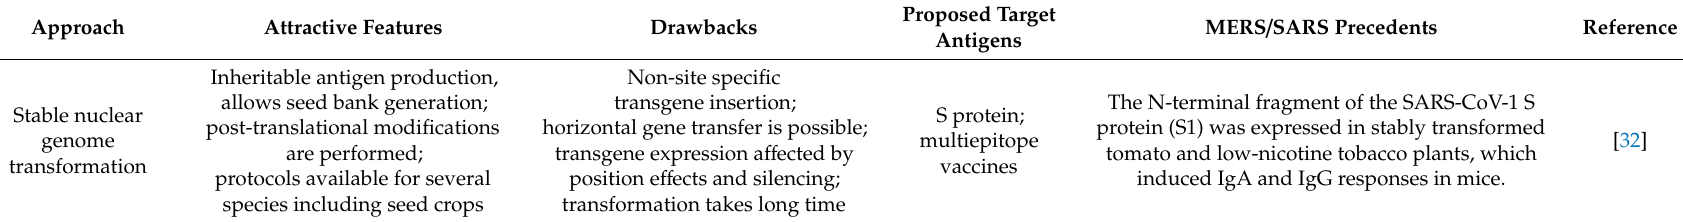
Table 1. Description of the expression approaches for the production of plant-based vaccines and precedents for MERS / SARS-CoV-1